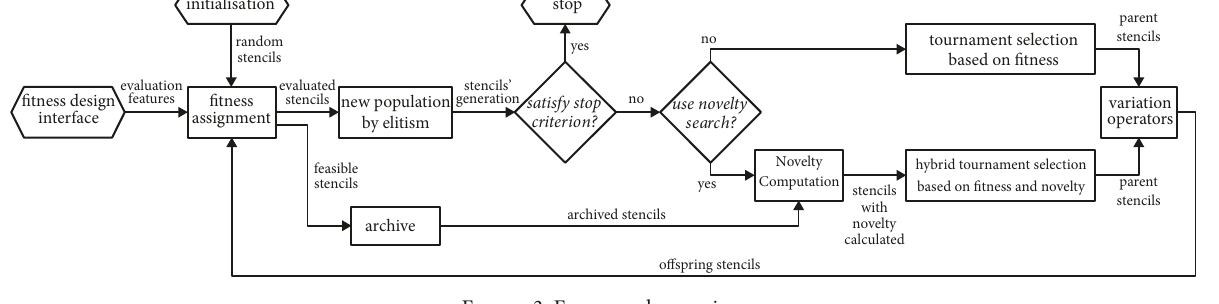
Figure 3: Framework overview.